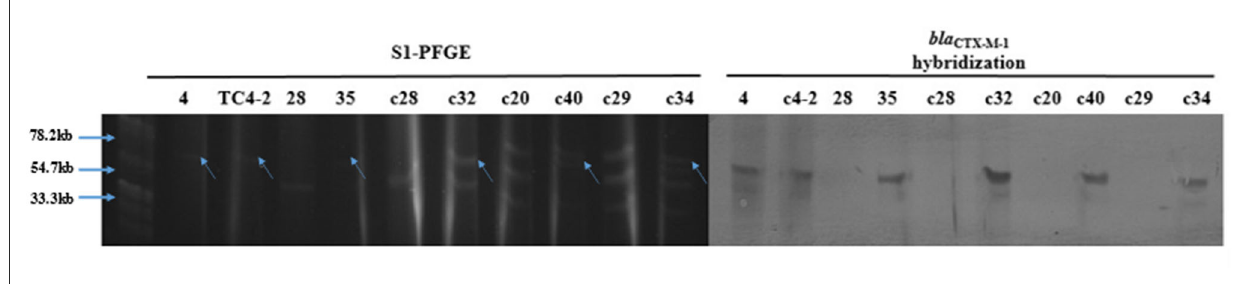
FIGURE6 S1-PFGE and Southern-blot hybridization of the donor and recipient isolates, and the corresponding transconjugants.